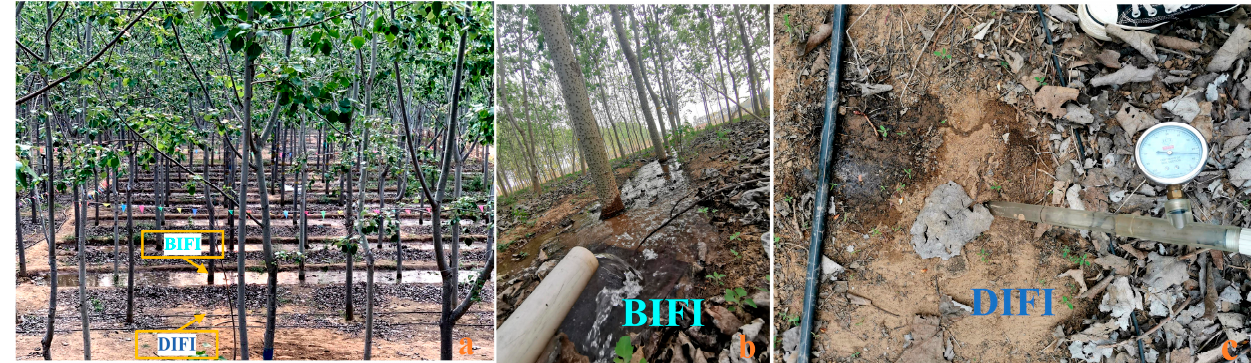
Figure 2. Schematic diagram of different irrigation methods in the test base:( a ) Base experiment, ( b ) BIFI Irrigation map, ( c ) DIFI Irrigation map ( b ) BIFI Irrigation map, ( c ) DIFI Irrigation